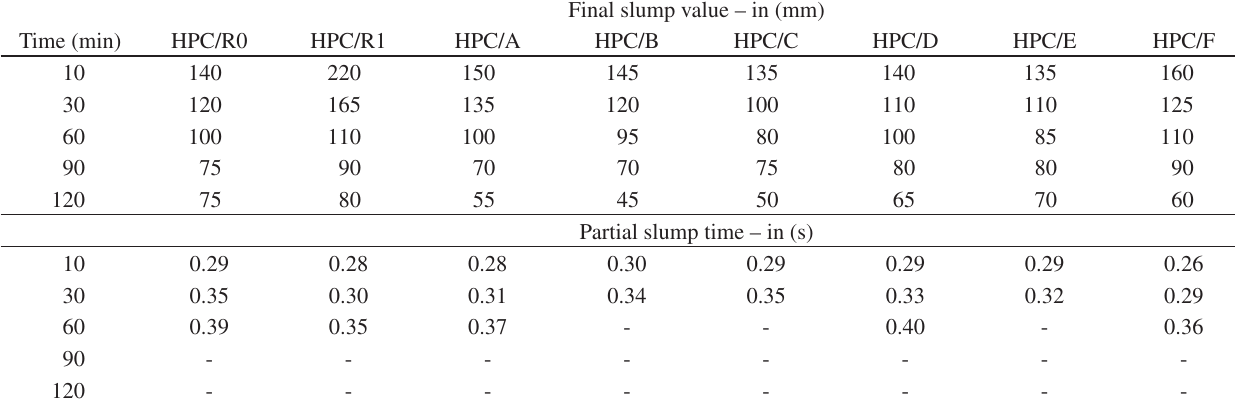
Final slump value – in (mm)